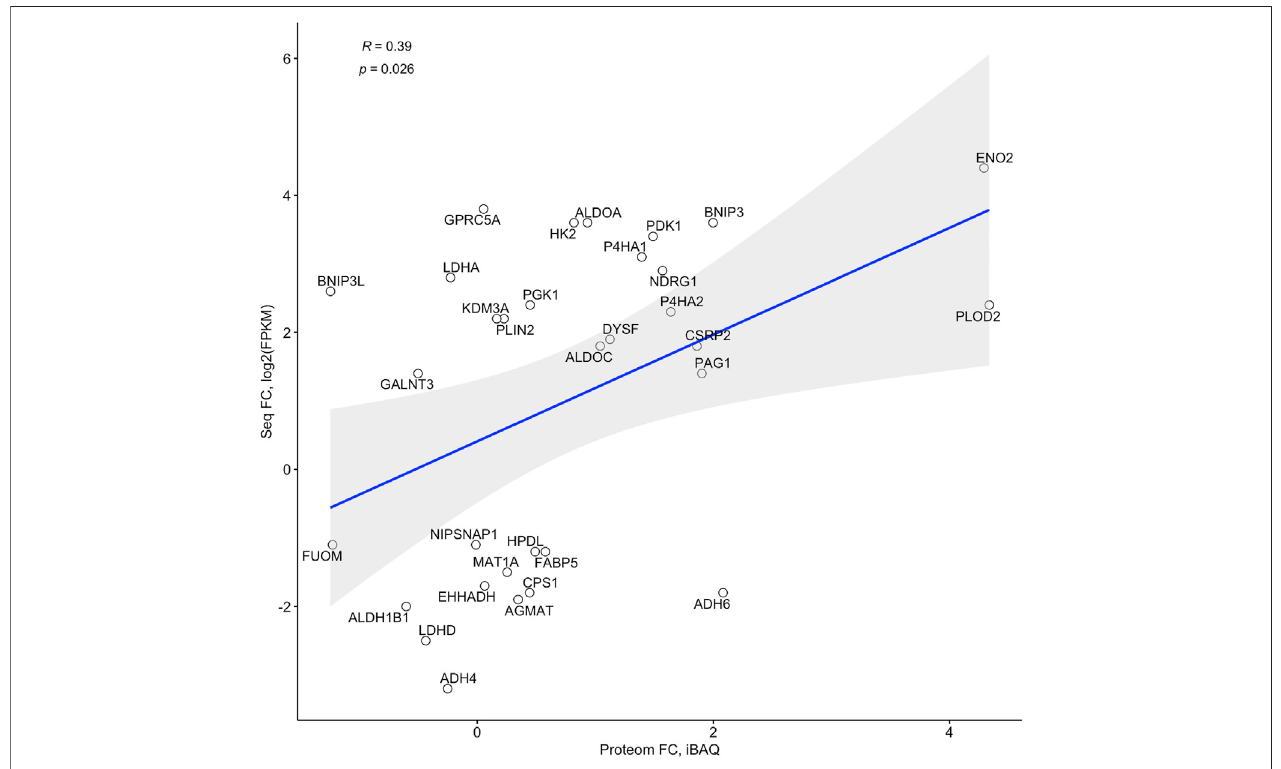
FIGURE 4 | Correlation of fold changes in the RNA sequencing (Seq FC) and proteome (Proteom FC) data in differentiated Caco-2 (dCaco-2) upon cobalt (II) chloride (CoCl 2 ) treatment.